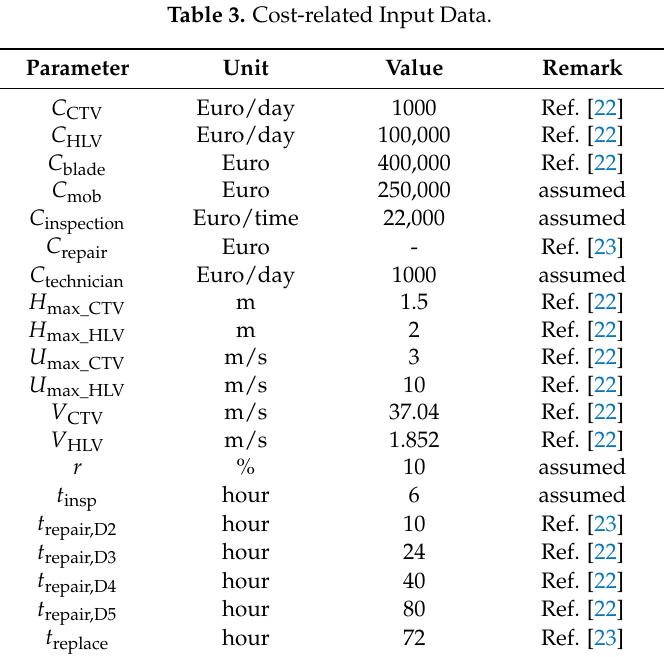
Table 3. Cost-related Input Data.